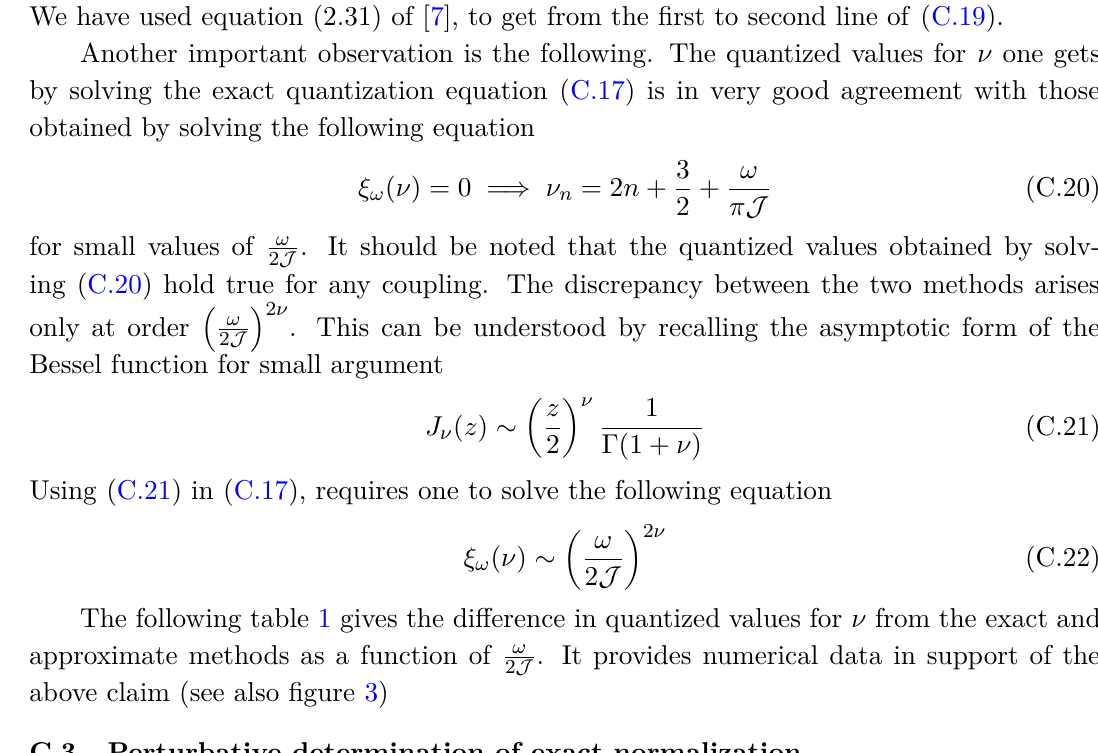
, which corresponds 2 J